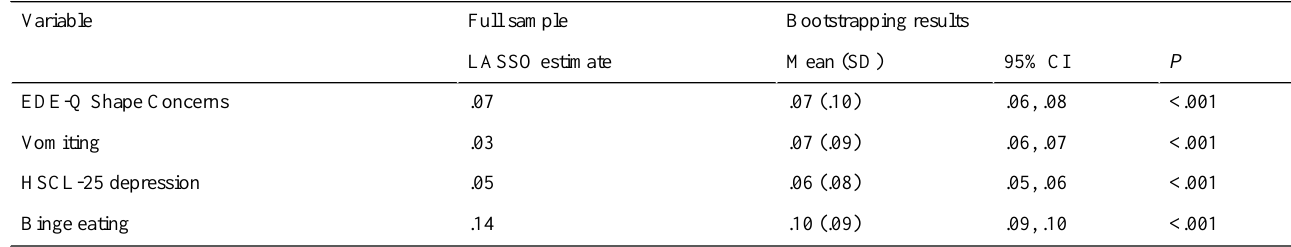
Table 2. Model parameters.